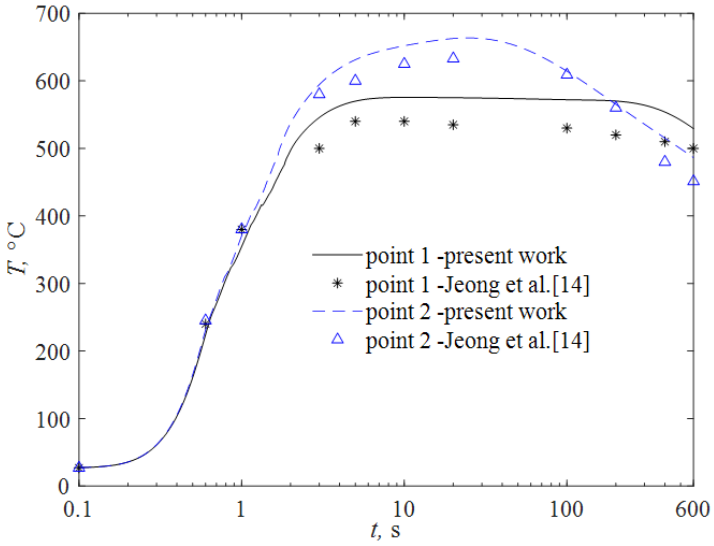
Figure 3. The comparison of the simulation results of this work with that of Jeong et al. [14].